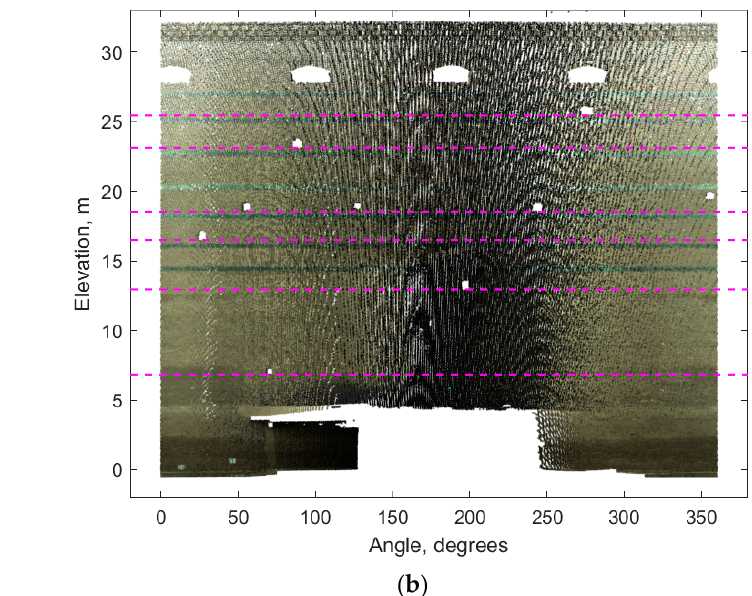
Figure 6. The unwrapped outer surface of the minaret with the elevations of all windows: ( a ) procedure of unwrapping the outer surface; ( b ) unwrapped surface (shifted by 180 degrees, so the north direction starts at 0 degrees and ends at 360 degrees): dashed lines indicate the window elevations.